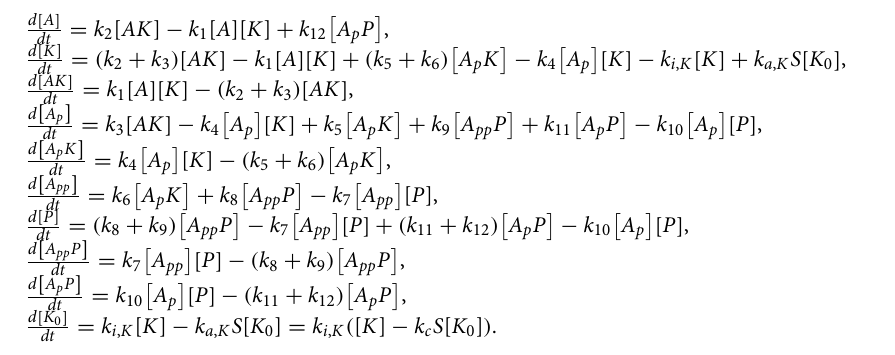
Figure 2: (a) scan of k a,K = k i,K vs. S; (b) scan of S for different k a,K = k i,K cases; (c) S = 0.1 for different k a,K = k i,K cases; (d) see plot legend. Figure 3: k a,K = k i,K = 0.65 in all panels. (a), (b) scan of k 3 vs. S; (c) scan of S for different k 3 cases; (d) scan of S for k 3 = 0.77; (e) scan of K act in the DP cycle for different k 3 cases; (f) see plot legend. Figure 4: k